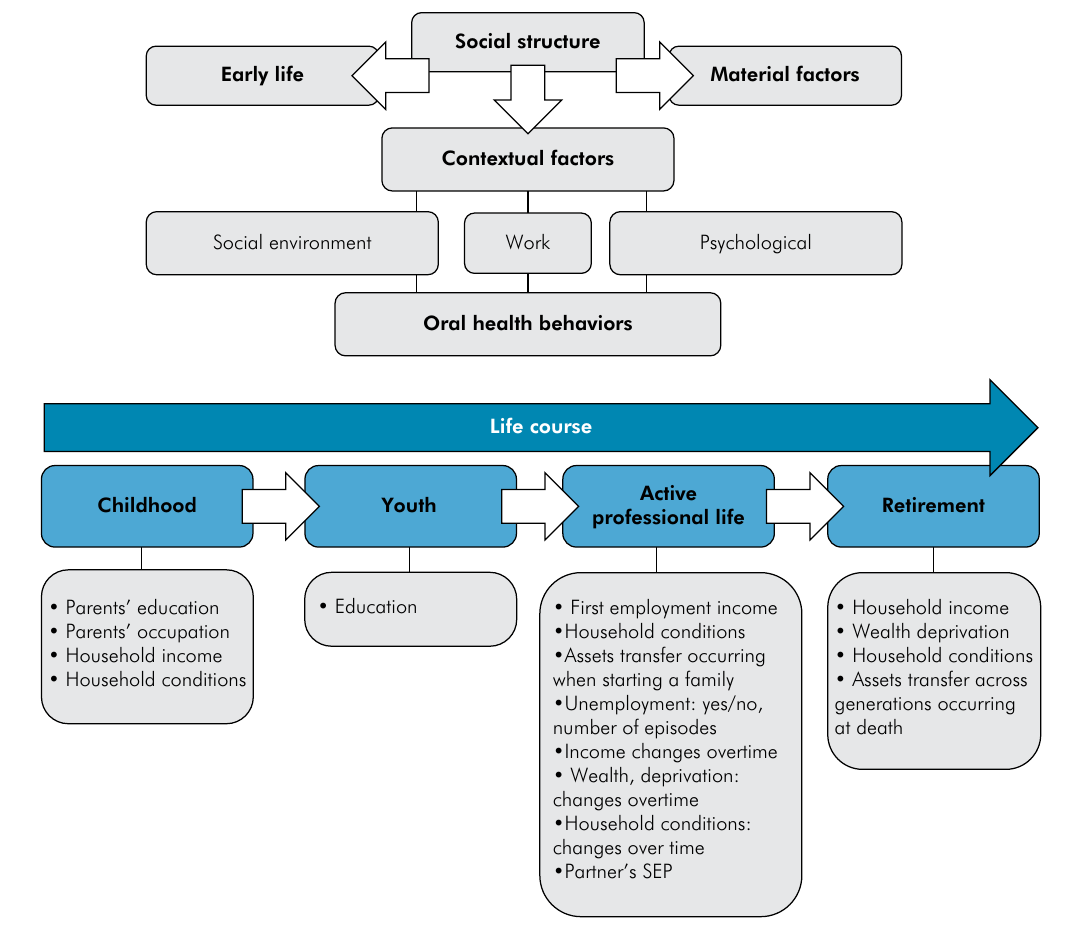
Figure 3. Indicators measuring life course socioeconomic position on an individual basis. Adapted from Galobardes et al. 21 and Thomson et al. 19